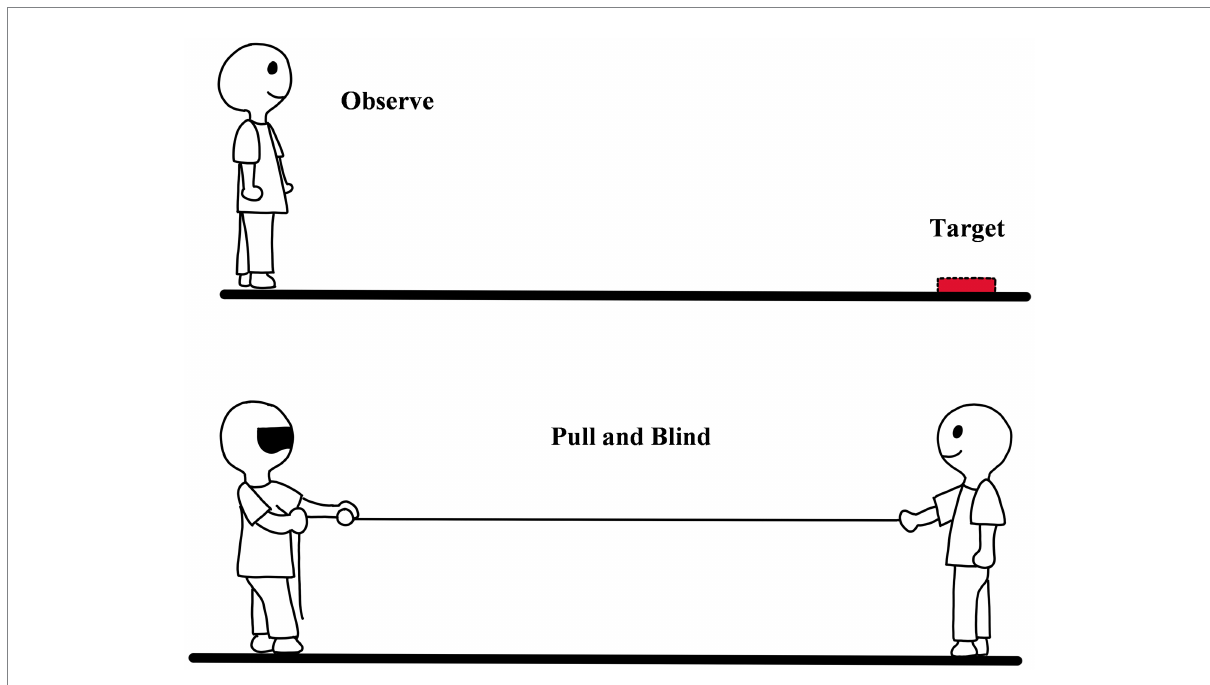
FIGURE 7 The diagram of blind rope